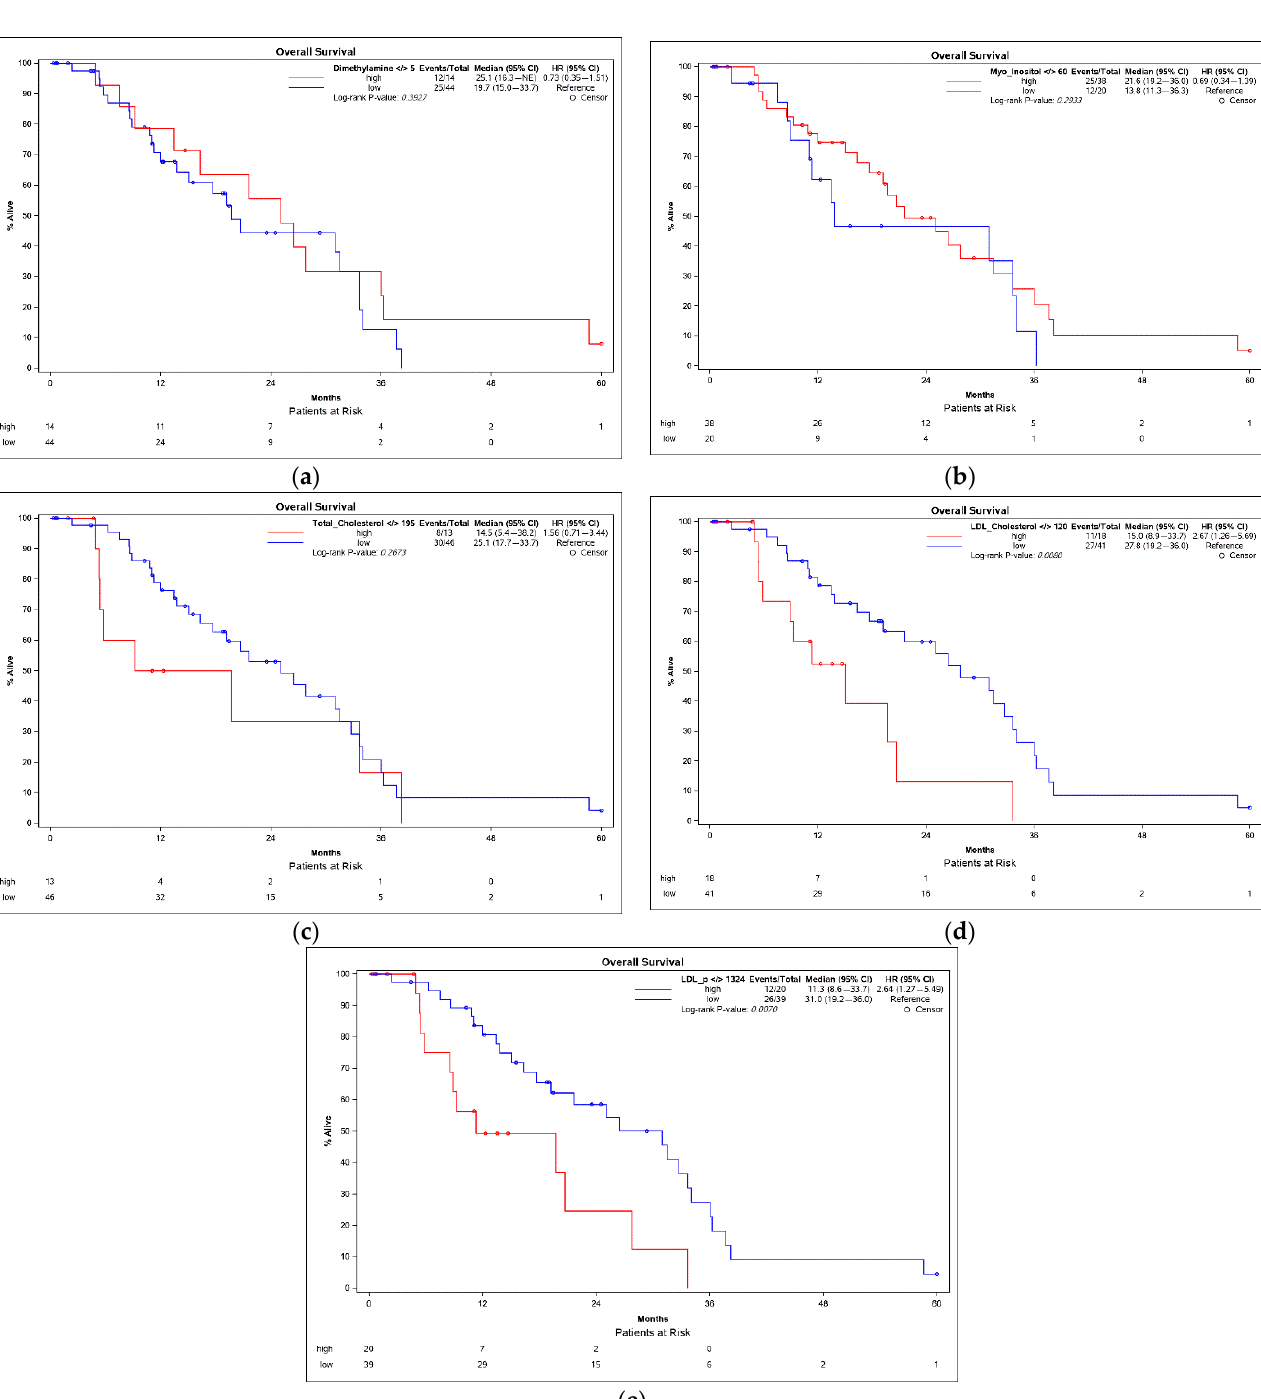
Figure 3. Kaplan–Meier survival analyses of HCC patients in correlation with the serum concentrations of dimethylamine ( a ), myo-inositol ( b ), total cholesterol ( c ), LDL-cholesterol ( d ) and LDL-P ( e ). The cut-off points for distinguishing between the high and low concentration values were determined by the Youden index. p -values were calculated using the log-rank test. CI = confidence interval; HCC = hepatocellular carcinoma.